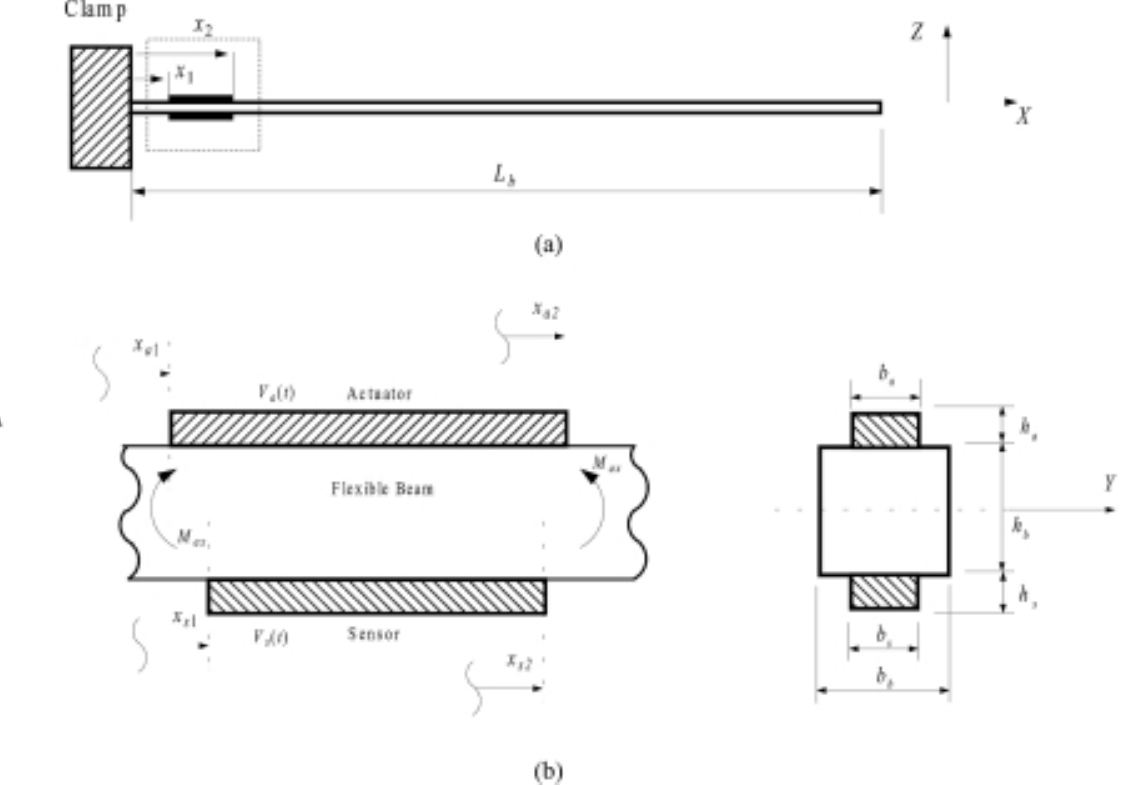
Fig. 1. (a) Flexible cantilever beam containing piezo-sensor and actuator and (b) Geometrical properties of the piezoelectric